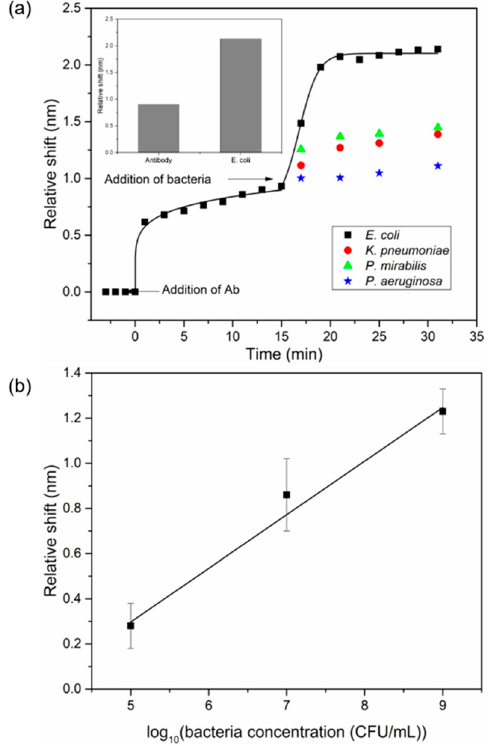
Figure 4. Selective uropathogenic Escherichia coli (UPEC) detection assay. ( a ) Real-time relative shift corresponding to capture of UPEC bacteria, and other UTI-causing Gram-negative bacteria at concentration 10 9 CFU/mL. Inset shows the relative cumulative shift in SPR signal observed after binding of UPEC-specific antibody and UPEC. ( b ) Relative shift corresponding to different concentrations of UPEC in PBS buffer (10 5 , 10 7 , 10 9 CFU/mL). Error bars indicate the standard deviation observed for each bacterial measurement for N = 3.